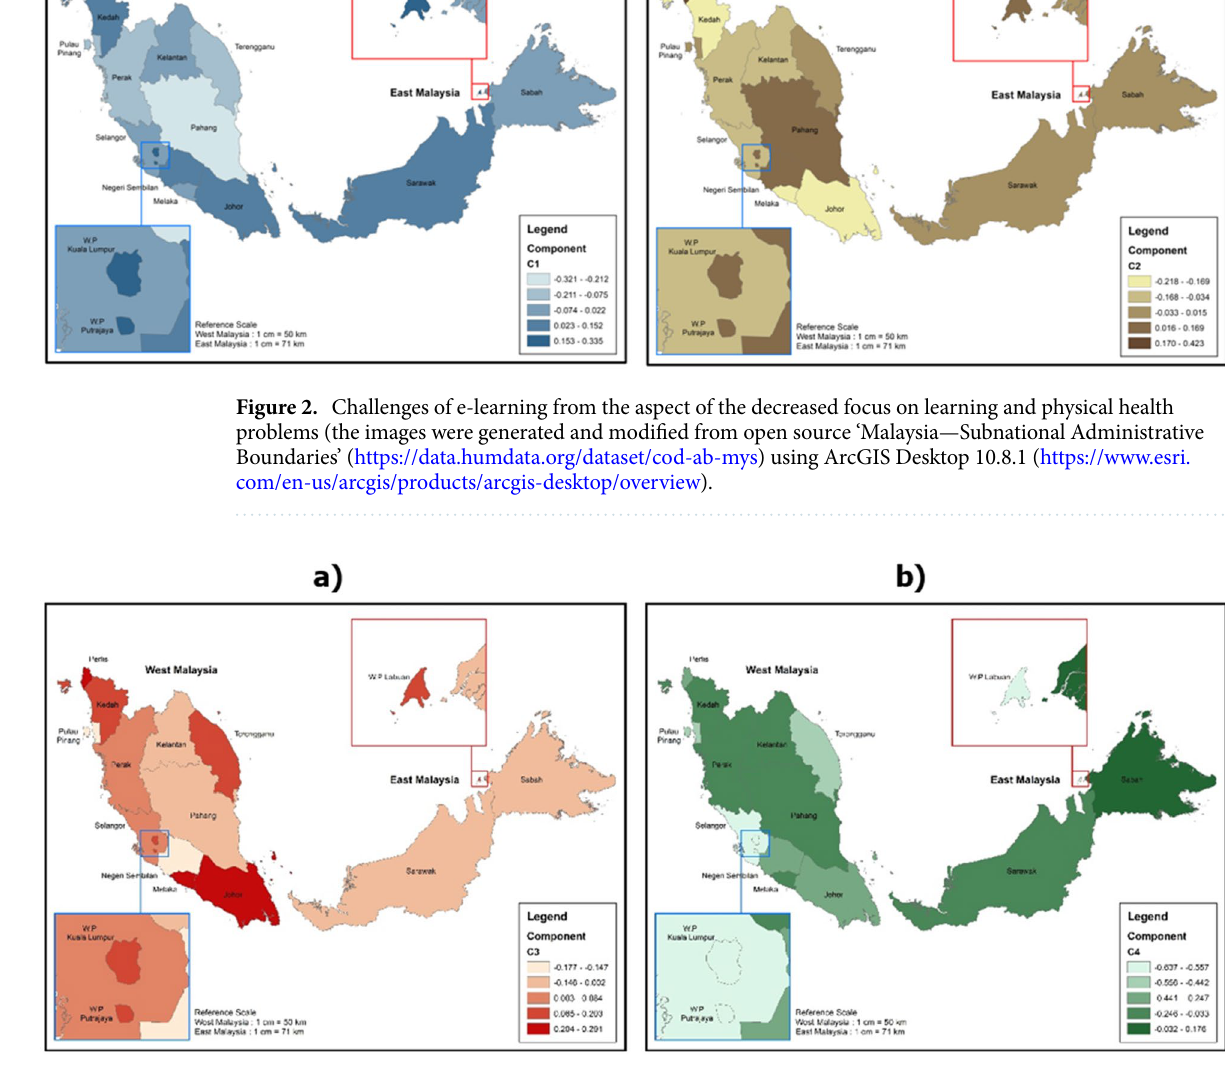
Figure 3. Challenges of e-learning from the aspect of mental health problems and, problems with technical and internet connection (the images were generated and modified from open source ‘Malaysia—Subnational Administrative Boundaries’ (https:// data. humda ta. org/ datas et/ cod- ab- mys) using ArcGIS Desktop 10.8.1 (https:// www. esri. com/ en- us/ arcgis/ produ cts/ arcgis- deskt op/ overv